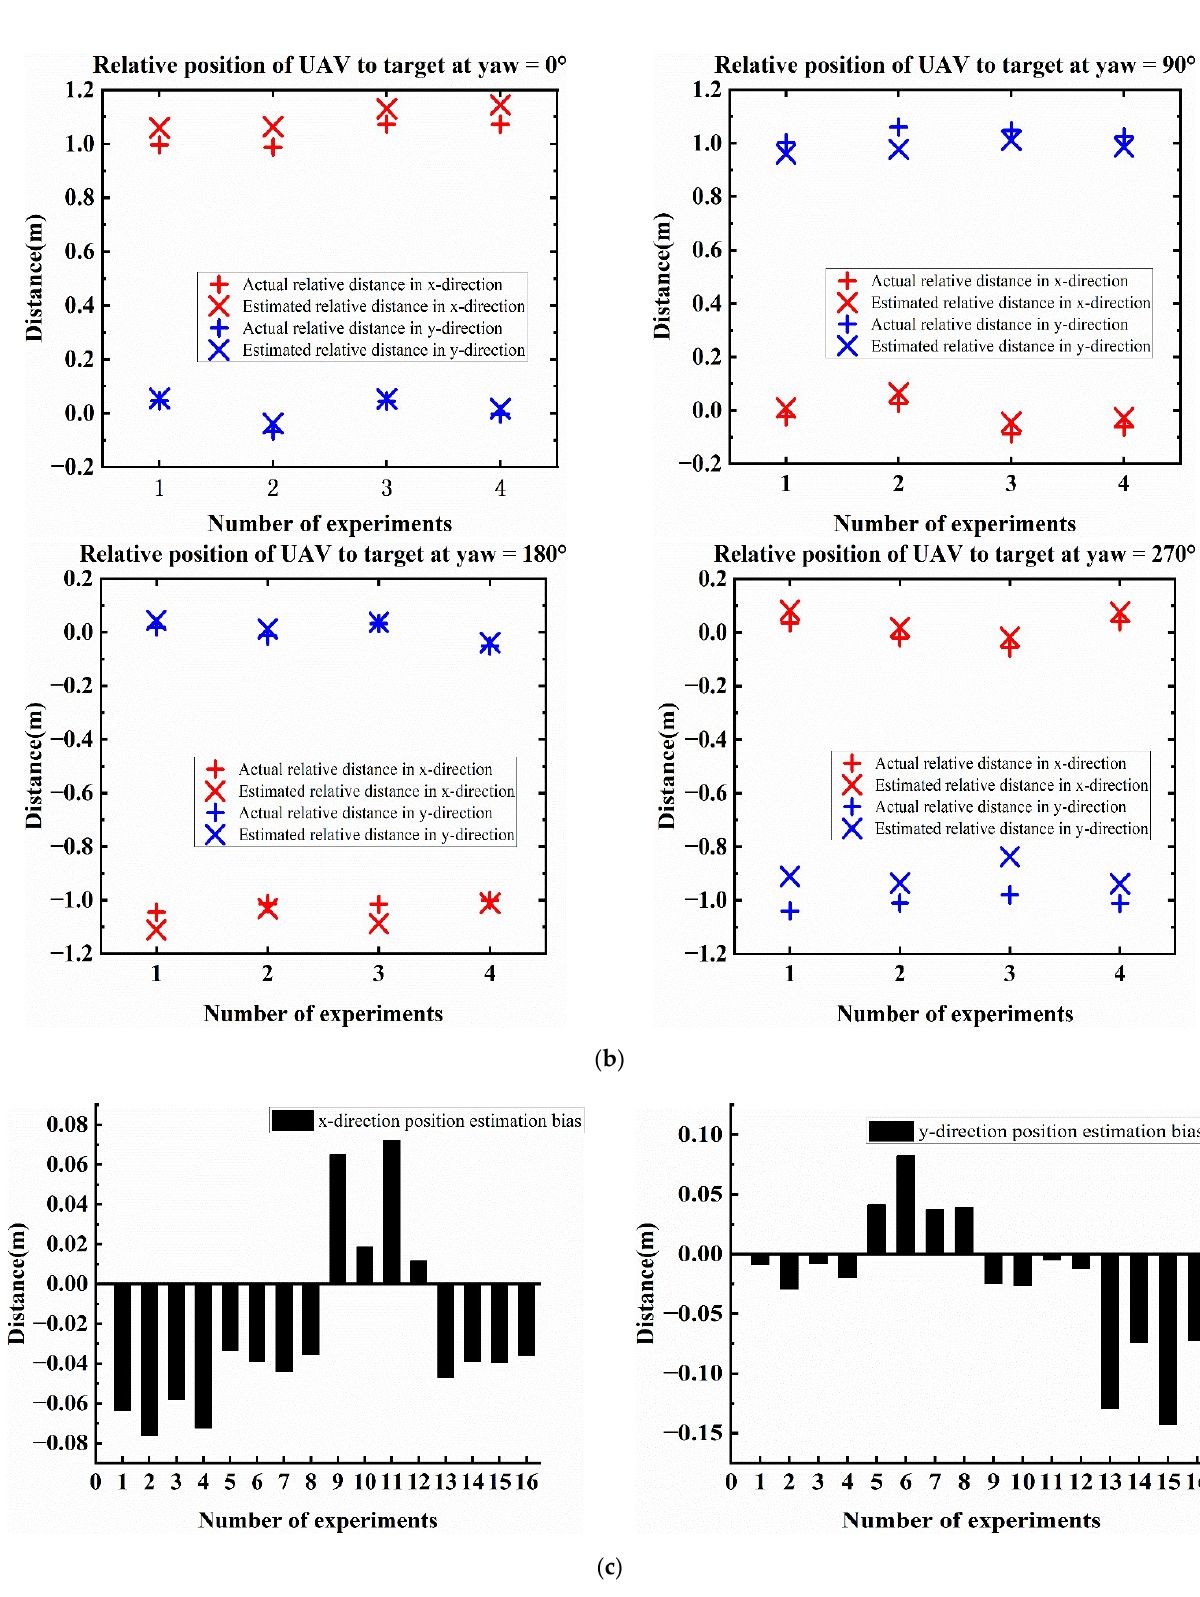
Figure 12. ( a ) True position of drone and target; ( b ) relative difference between real and estimated distance; and ( c ) bias in relative position estimation algorithm. Based on the monocular camera information from the UAV, the pixel coordinates of the target were detected and the relative position was estimated. The estimation bias was